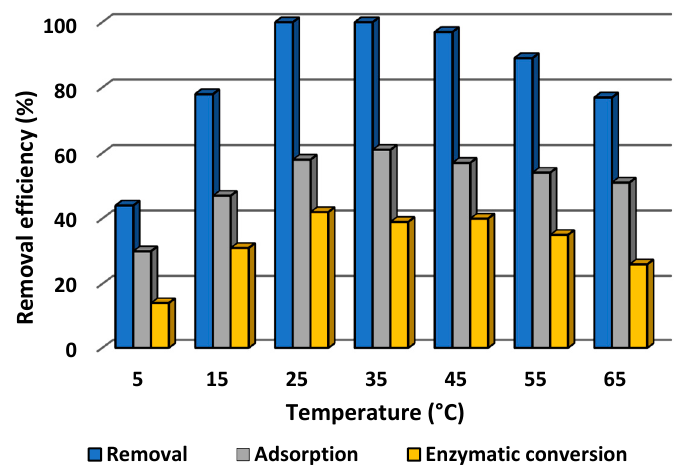
Figure 8. Effect of temperature on the efficiency of adsorption, enzymatic conversion and total removal of tetracycline by laccase immobilized on chitin scaffolds. The error value in each of the experiments (based on the mean and standard deviation from three experiments) does not exceed 3.5%. Adsorption efficiency denotes the efficiency of adsorption by the chitinous scaffolds with immobilized laccase following thermal inactivation.